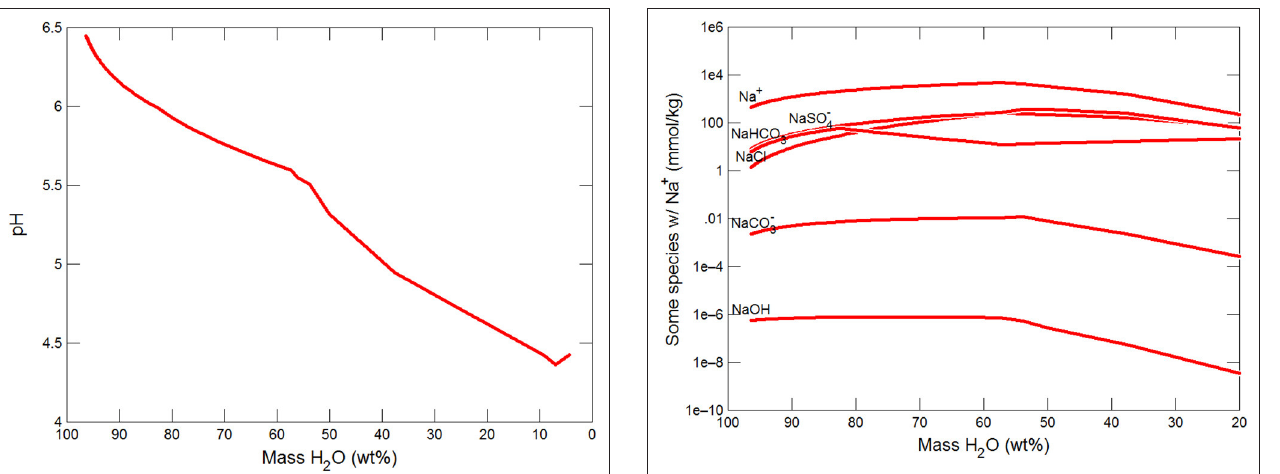
FIGURE 9 | Variations in Na species during freezing of seawater.